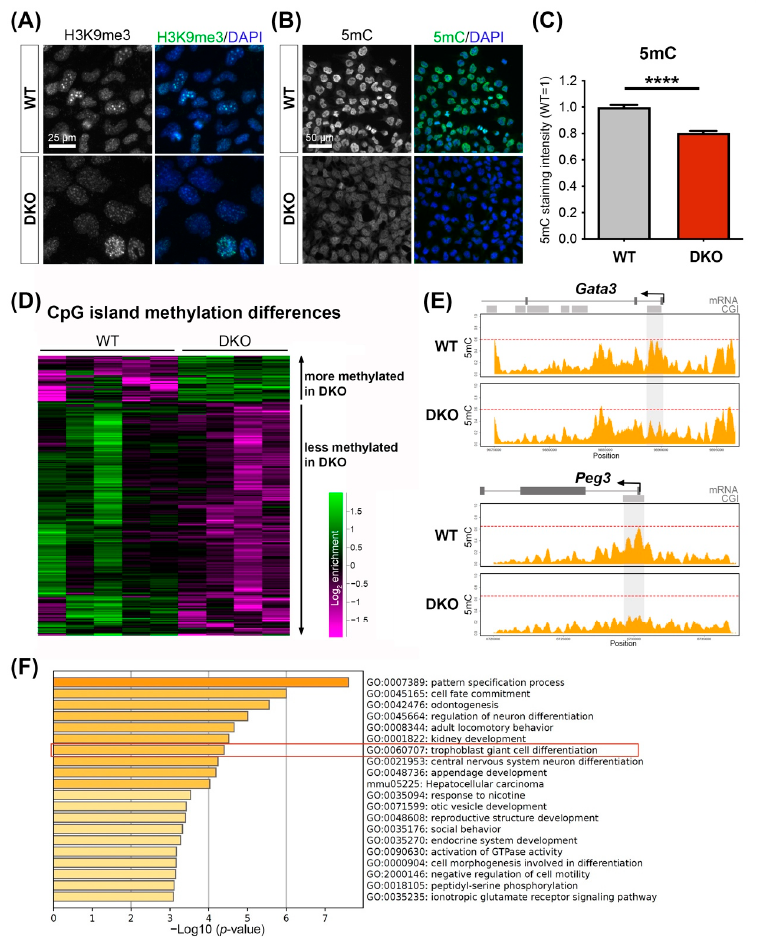
Figure 4. Padi2/3 DKO TSCs exhibit an altered epigenomic landscape. ( A ) Immunofluorescence staining for H3K9me3 on WT and Padi2/3 DKO TSCs reveals fewer bright heterochromatic foci (chromocentres) and instead, an overall reduced and more finely dispersed staining pattern of this heterochromatic mark in Padi2/3 DKO cells. ( B ) 5-methylcytosine (5mC) immunostaining on WT and Padi2/3 DKO TSCs. ( C ) Quantification of 5mC fluorescence intensities shows reduced amounts of 5mC in DKO cells. Statistical analysis by unpaired Student’s t-test (**** p < 0.0001; n = 4 independ- ent clones per genotype with >150 cells assessed each). ( D ) Heatmap of read count enrichment across developmentally regulated CpG islands (CGIs) [32] as determined by meDIP-seq profiling. ( E ) Wig- gle plots of 5mC enrichment across the Gata3 and Peg3 loci. Gene structure (exons) and CGIs are displayed on top of the graphs. The differentially methylated CGIs are shaded. The red dotted line demarcates the level of maximal enrichment in WT cells, and is drawn at corresponding levels in the DKO graph to help visualize the reduction in 5mC enrichment. ( F ) Metascape gene ontology